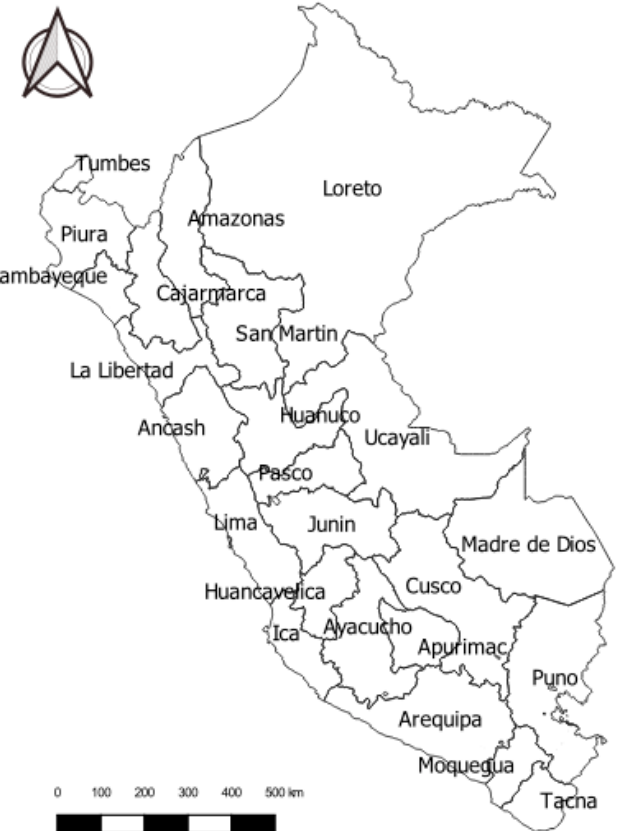
Figure 1. Map of the departments of Peru according to a political-administrative division (own elaboration using QGIS).